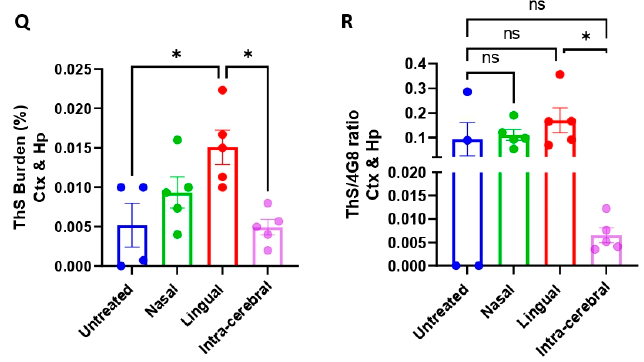
Figure 5. Thioflavin ‐ S staining in the cortex and hippocampus of experimental and control animals. Representative pictures of ThS staining for analysis of fibrillar A β aggregates in the cortex ( A – G ) and hippocampus ( B – H ) of control and experimental mice. Higher magnification pictures of A β plaques in the hippocampus after staining using the ThS dye (green, I , K , M , O ) or the 4G8 antibody (red, J , L , N , P ) in the consecutive brain section. ThS burden (%) quantification in both cortex and hippocampus brain areas of untreated and extra ‐ nasal or intra ‐ lingual challenged animals ( Q ). Individual values in O were divided by the 4G8 burden found for each animal group as displayed in Figure 2 I to calculate the ThS/4G8 burden ratio ( R ). Values are expressed as mean ± SD. Statistical analyses were performed using One ‐ way ANOVA and Tukey test (* p < 0.05). Scale bar represents 100 μ m ( A – H ) and 50 μ m ( I – N ). ns: not significant.